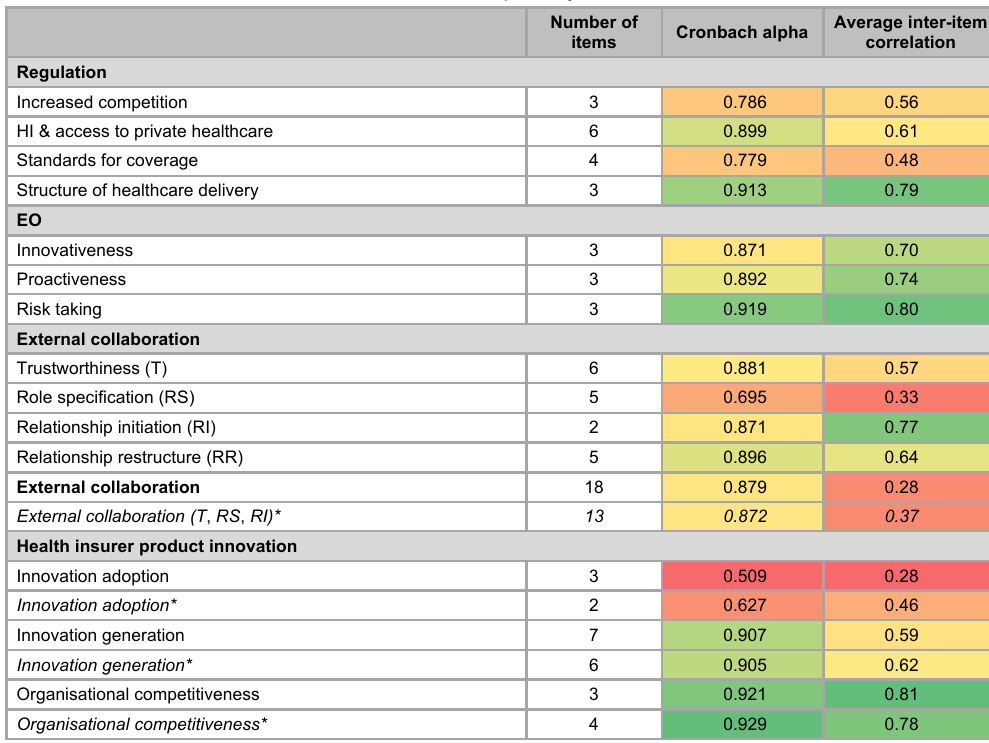
Number of items